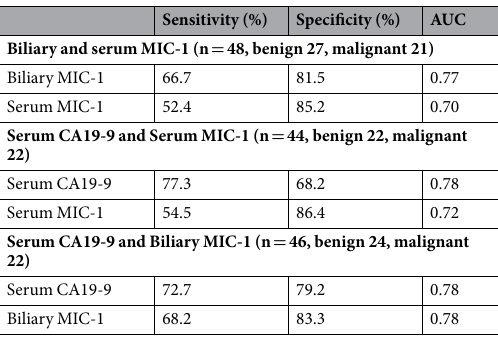
Sensitivity (%) Specificity (%)